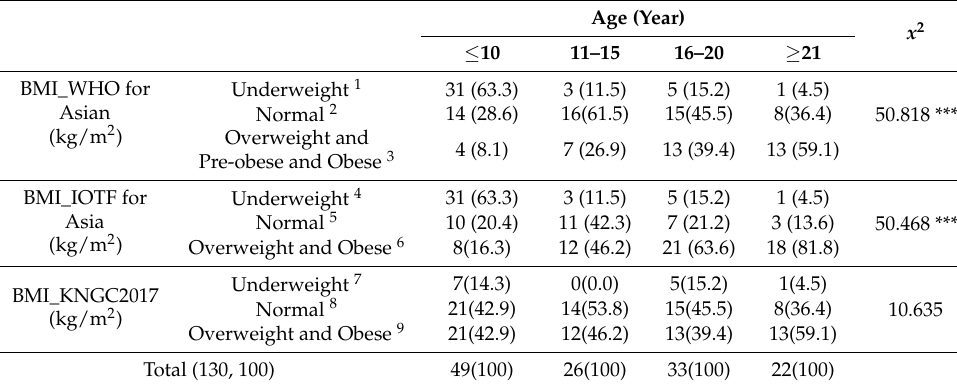
Table 2. Obesity status according to